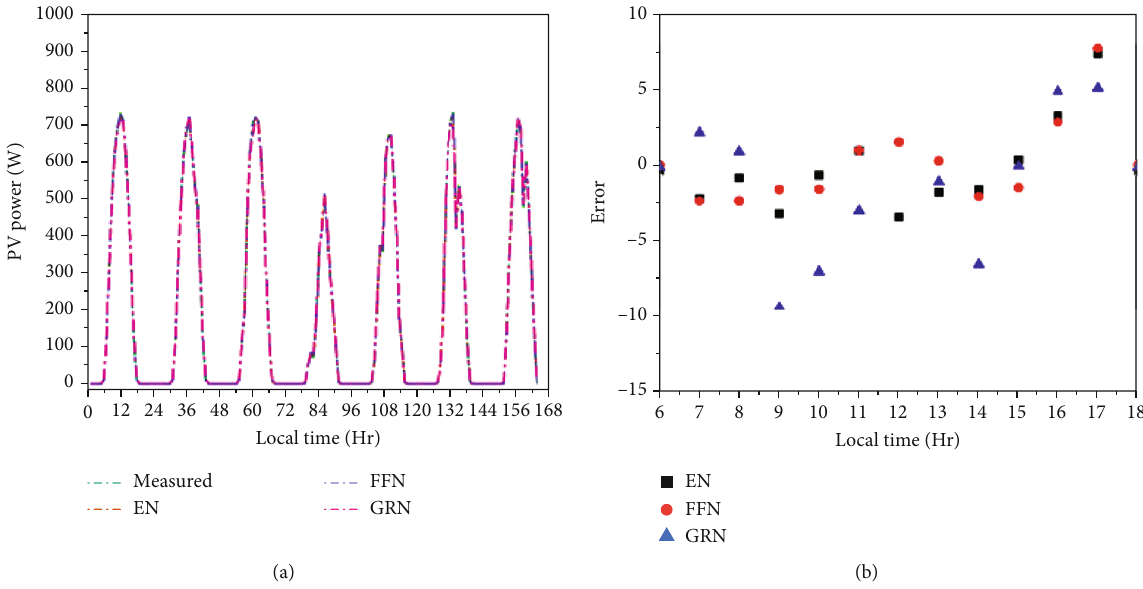
Figure 11: Daily variation of the BISTPV system. (a) DC output power of EN, FFN, and GRN. (b) Error of the EN, FFN, and